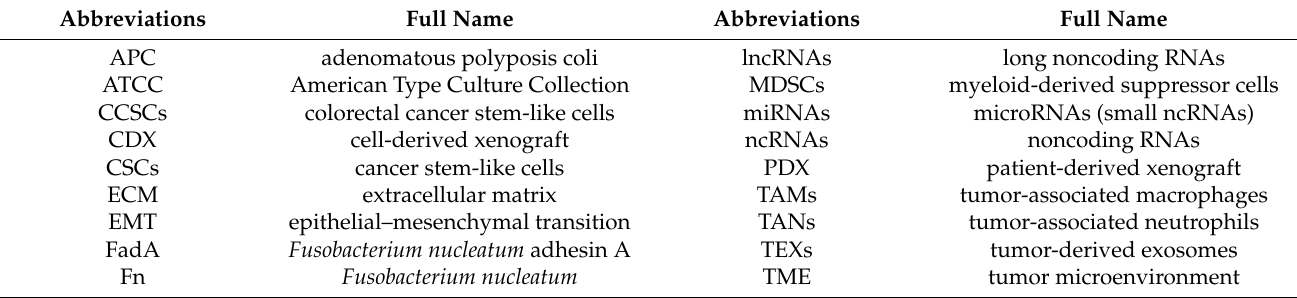
Table 1. Abbreviations used in this